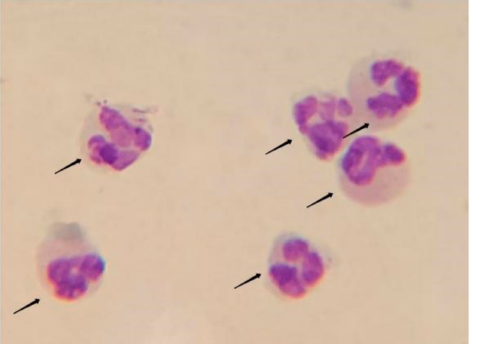
Figure 2. Morphology of neutrophils. Neutrophils were stained with Wright-Giemsa. Black arrows indicate neutrophil.